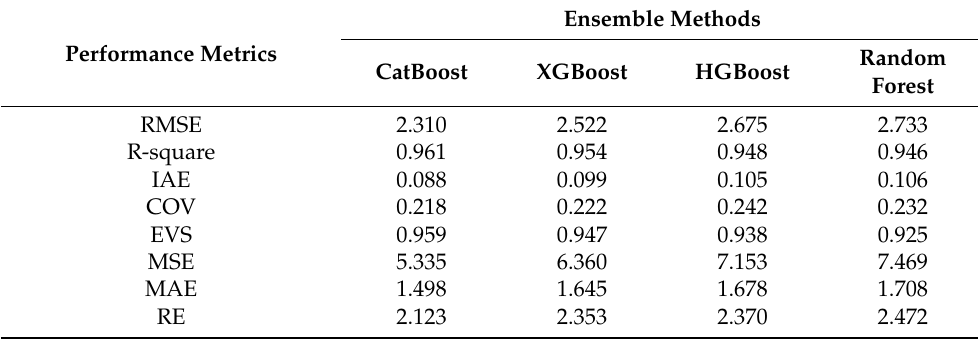
Table 3. Performance comparison of the ensemble methods.